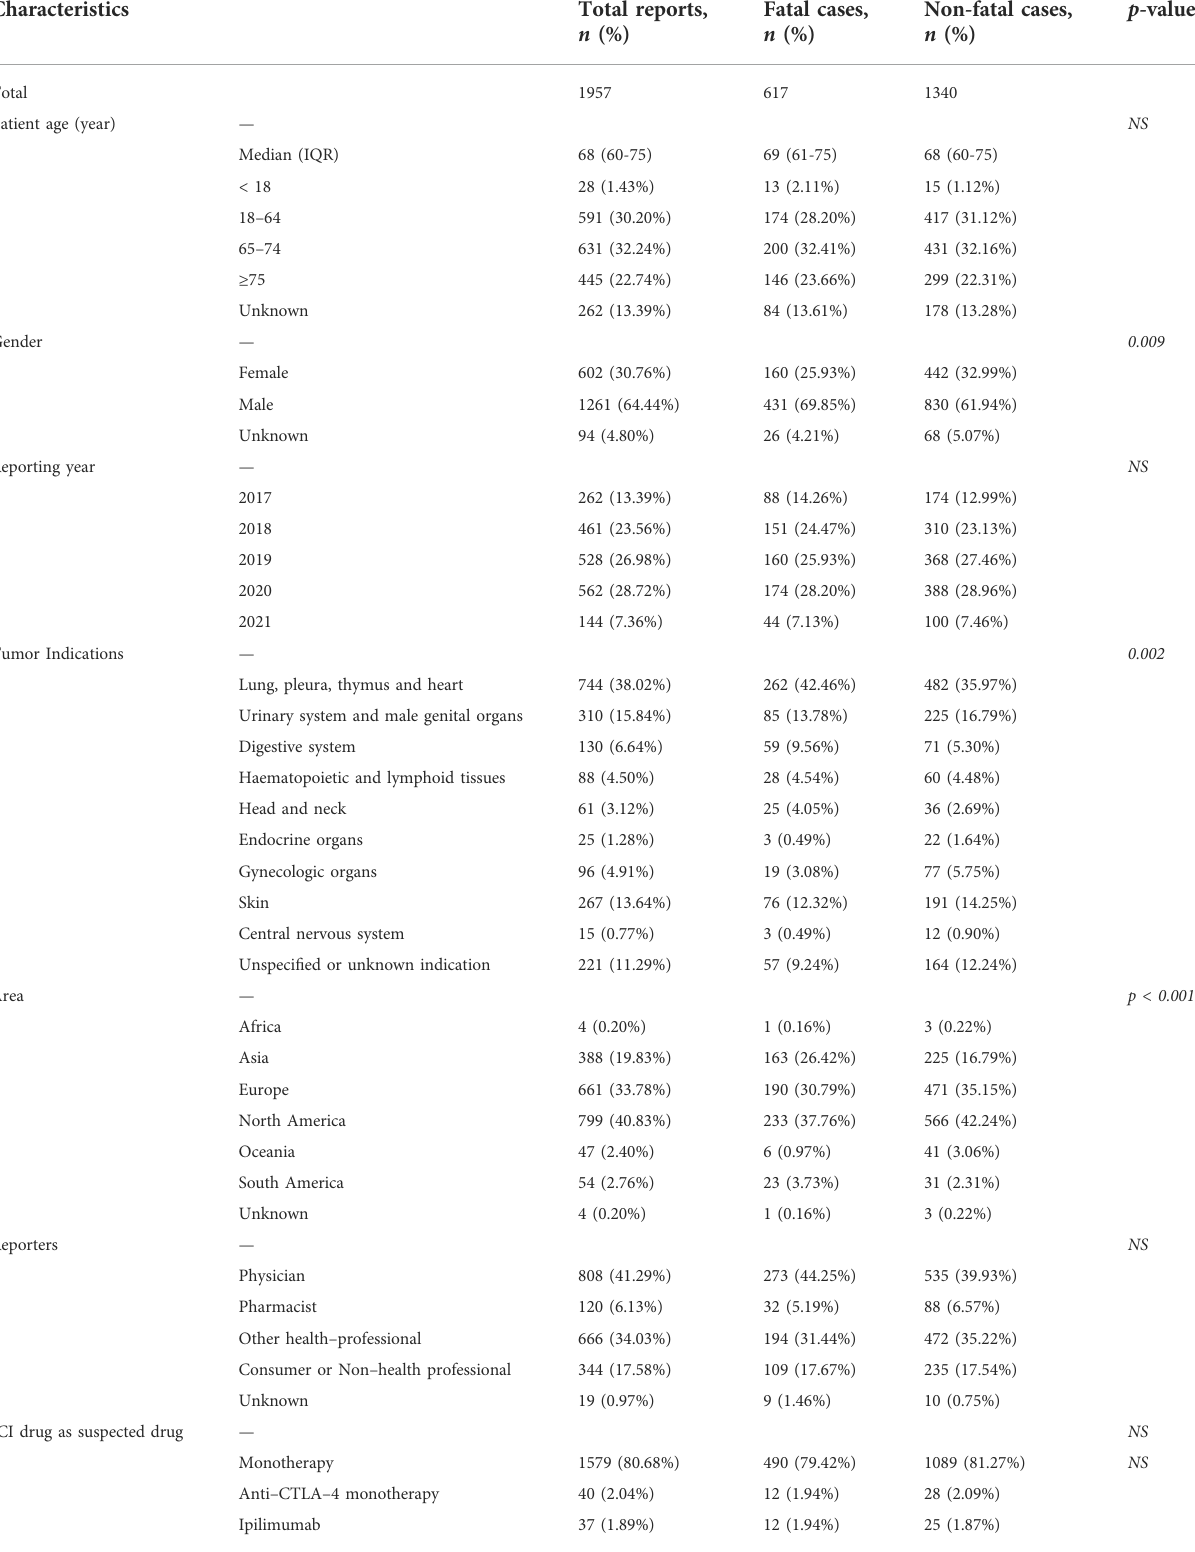
TABLE 1 Characteristics of patients with ICI-associated cardiac arrhythmias sourced from the FAERS database (January 2017 to June 2021).